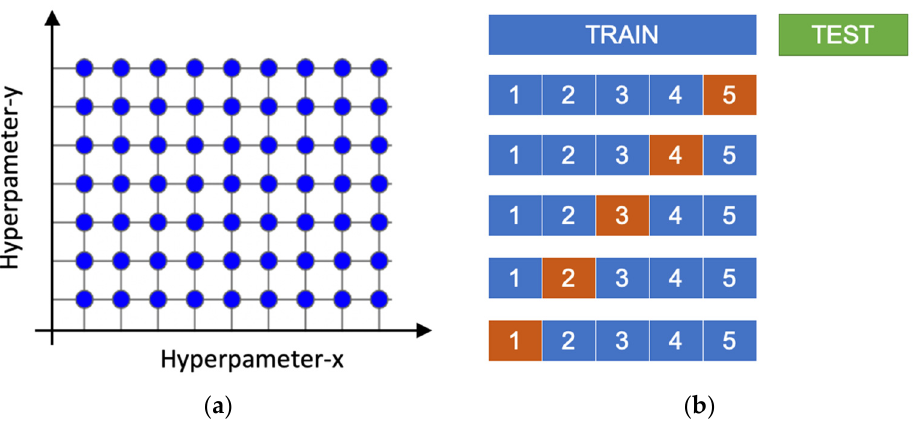
Figure 2. ( a ) Example of a grid search domain, where the hyperparameters are distributed into a matrix. ( b ) A schematic representation of 5-fold cross-validation. In ( b ), the data train (the blue boxes) is split in “k” subsegments, and one (the orange box) of them is used as the validation in each